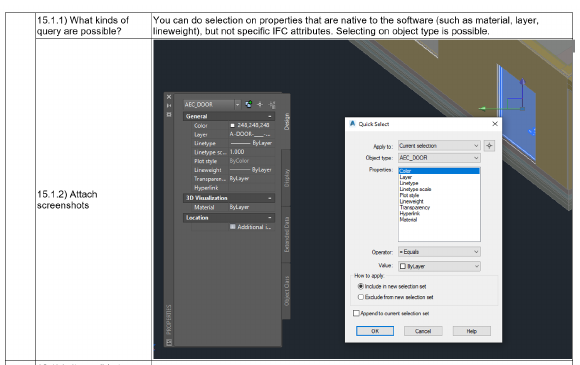
Figure 1. Sample response returned for Task 1, showing possible queries in the Autodesk Civil 3D Software Package